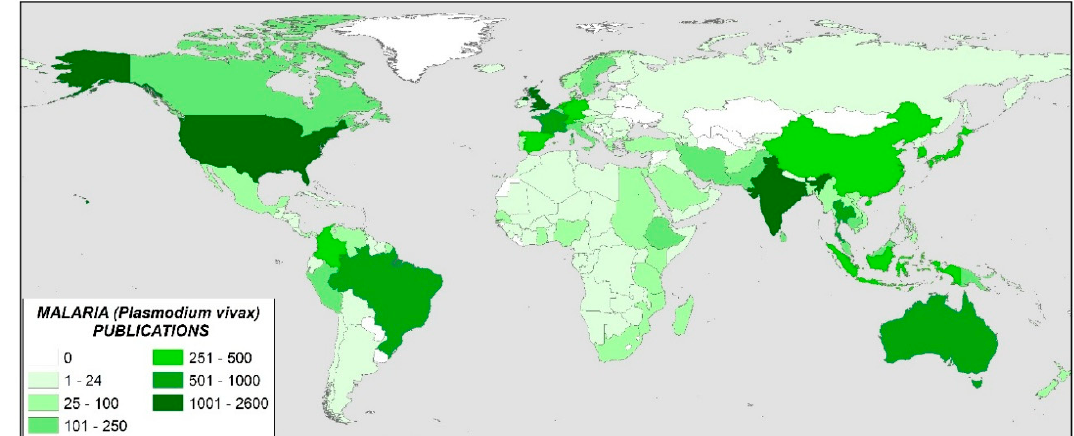
Figure 4. World map representing scientific publications by the intensity of color.